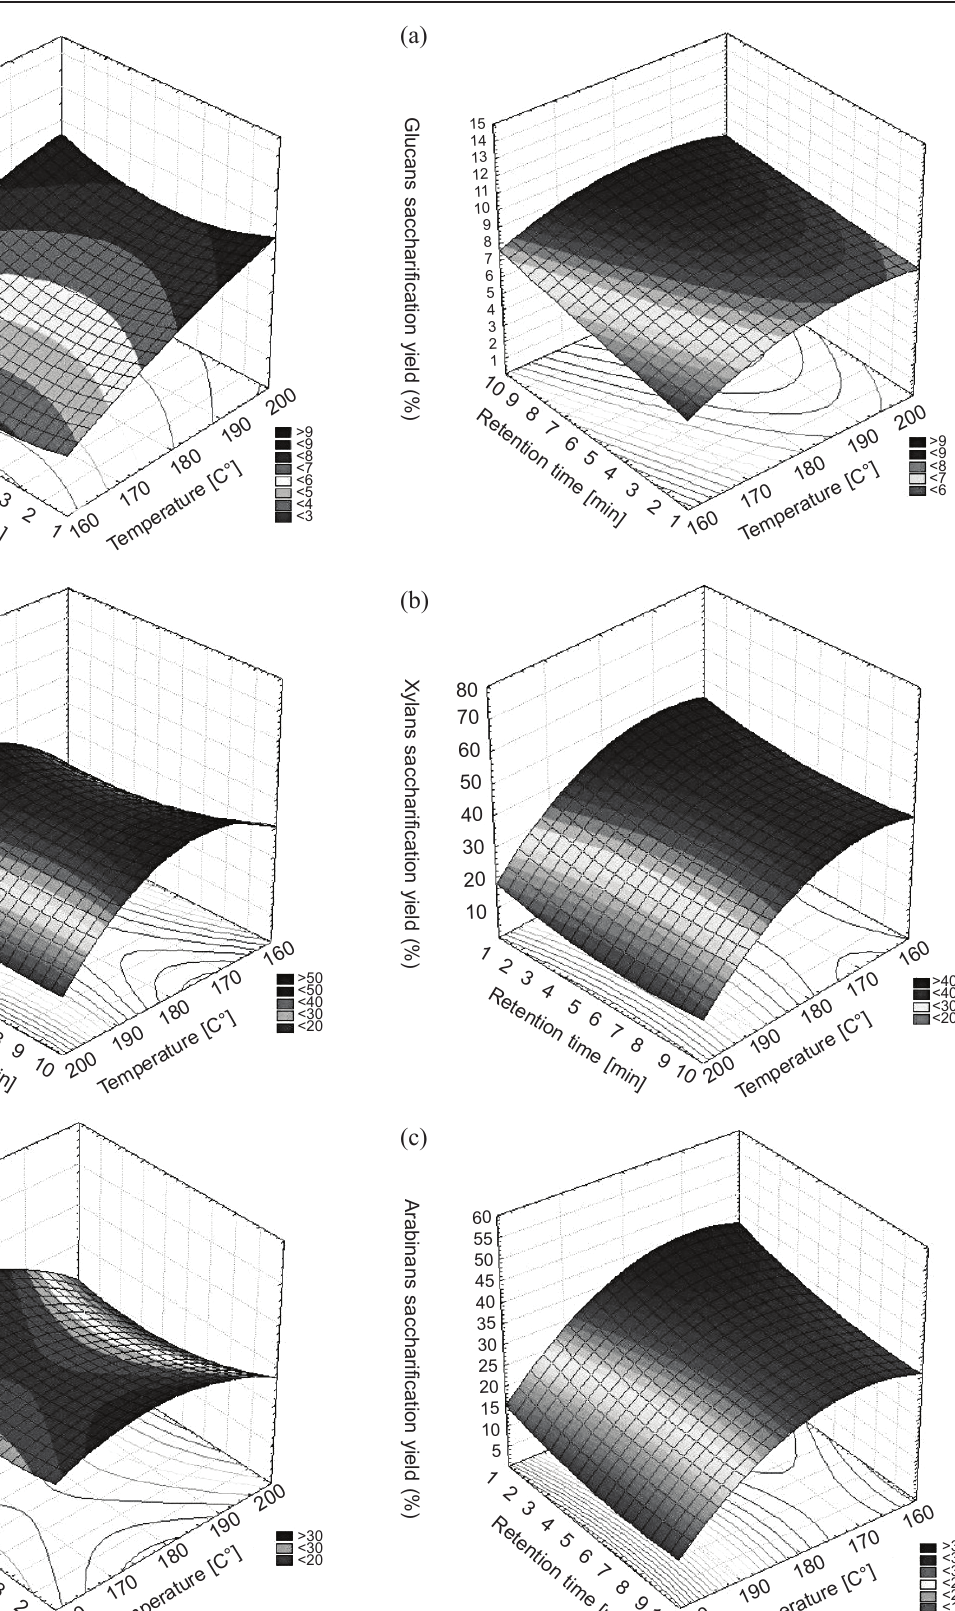
Fig. 2 – Saccharification yield of: a) glucans, b) xylans, and c) arabinans in the liquor wheat straw hydrolysate after diluted